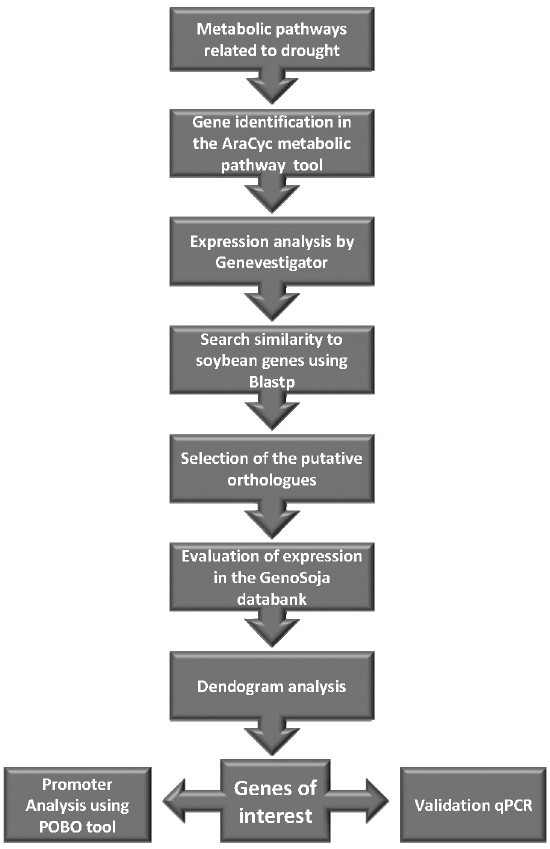
Figure 1 - Strategy of ortholog gene search in soybean subjected to drought stress.